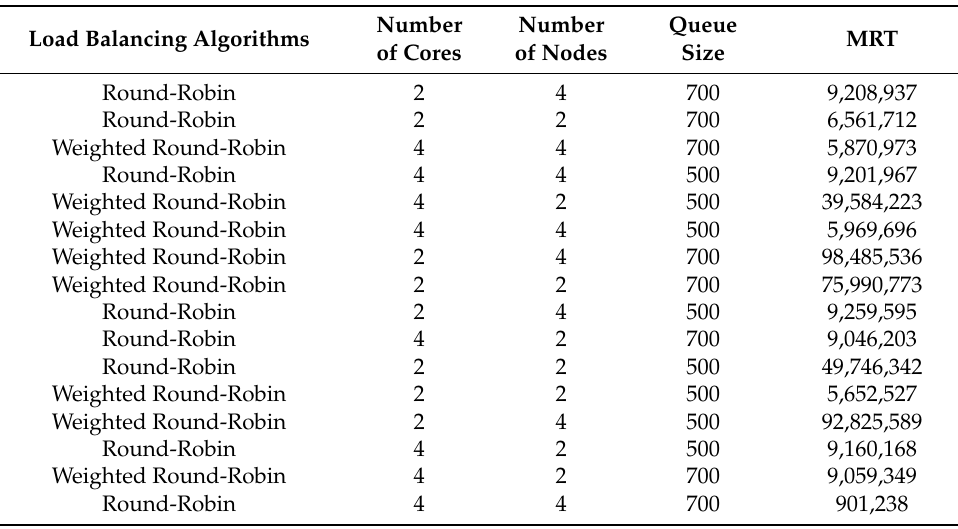
Table 3. Factors and their respective level